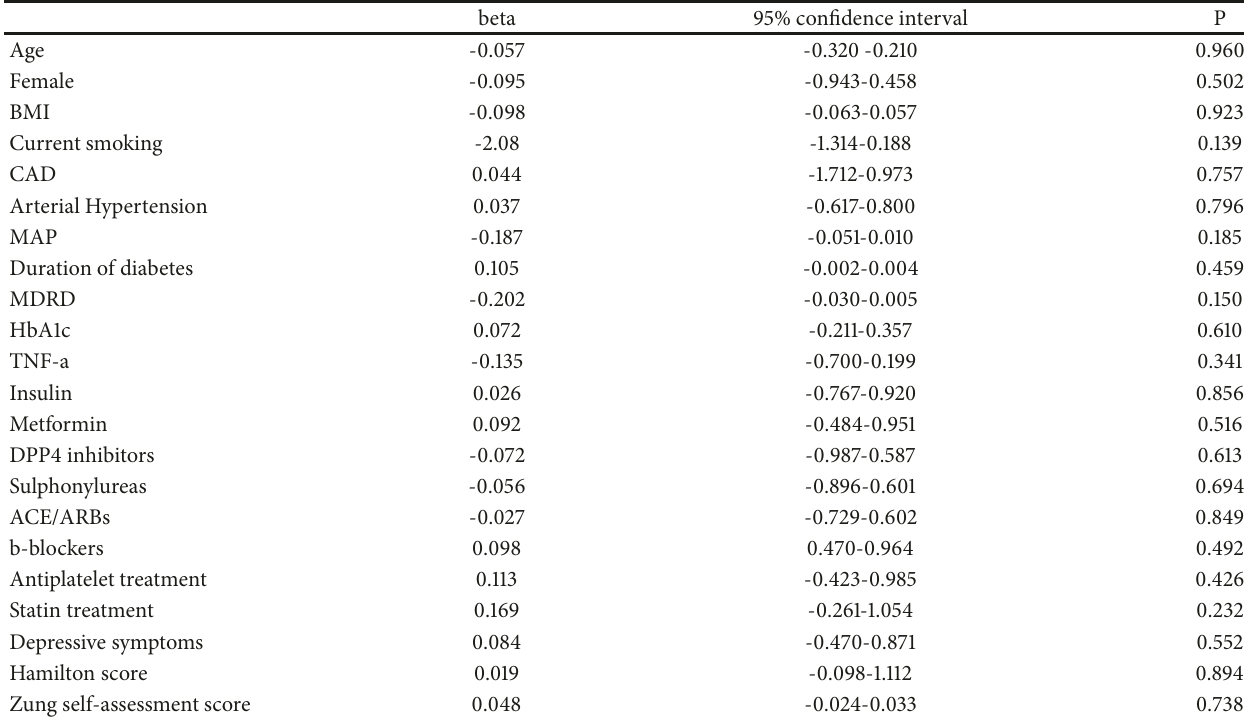
Table 3: Linear regression of patients’ characteristics with